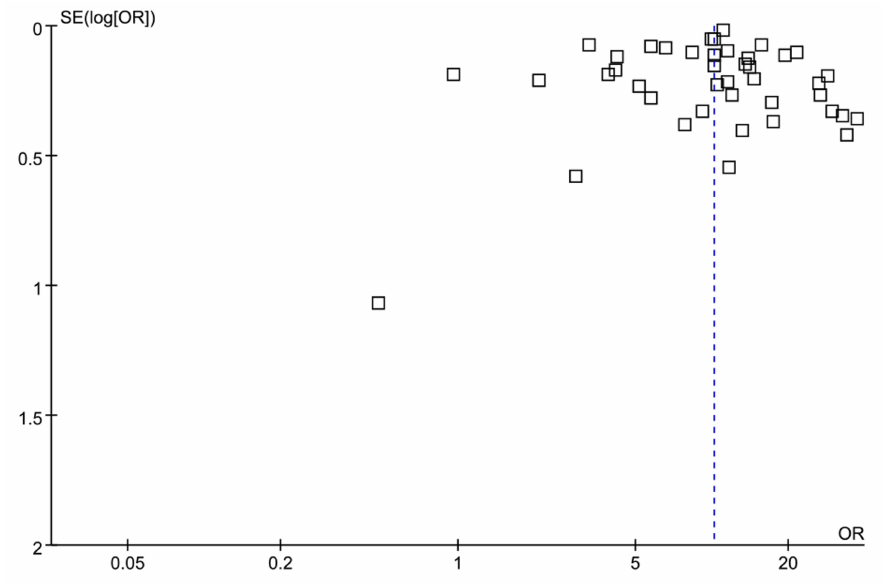
Figure 5. A funnel plot of the articles publication for the duration of drug